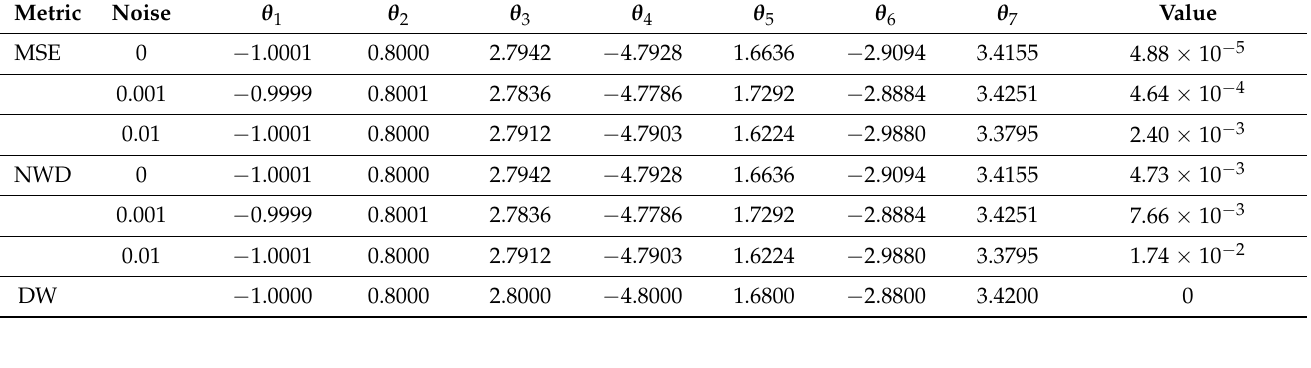
Table 3. Comparison of the estimated parameter values with the actual parameters of Problem 2.